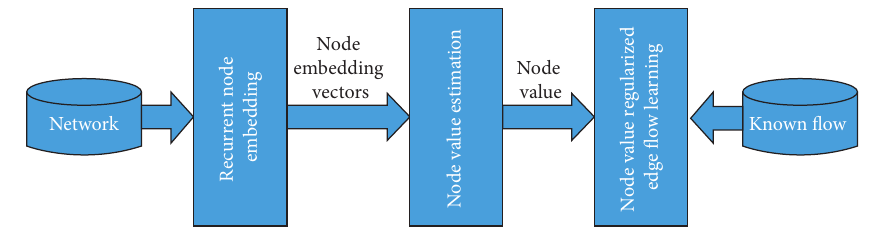
Figure 1: Flow chart of proposed semisupervised flow learning